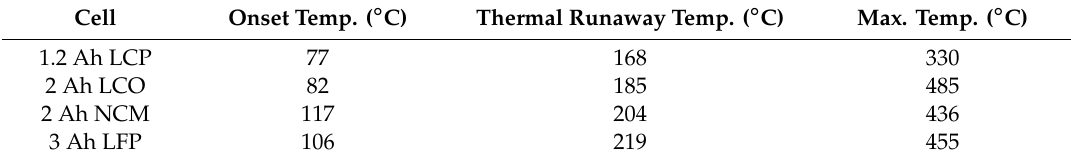
Figure 4. Temperature versus time for thermal decomposition of selected batteries at 100% SOC ( a ) and the dependence of self-heating-rate on temperature of selected batteries at 100% SOC ( b ). The thermal runaway temperature is defined as the temperature self-heat-rate ≥ 10 ◦ C min − 1 . Table 2. Onset, thermal runaway, and maximum temperatures of the examined batteries at 100% SOC. Cell Onset Temp. ( ◦ C) Thermal Runaway Temp. ( ◦ C) Max. Temp. ( ◦